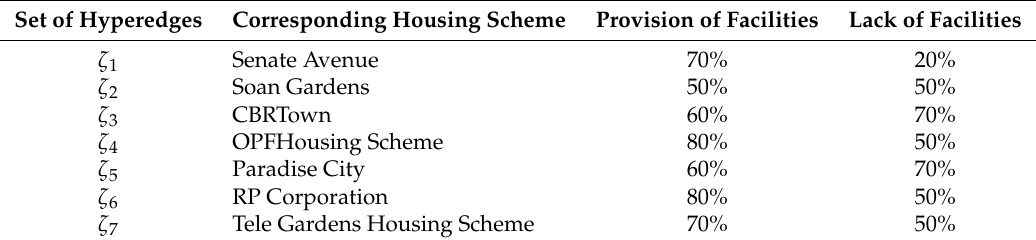
Table 5. Description of hyperedges.